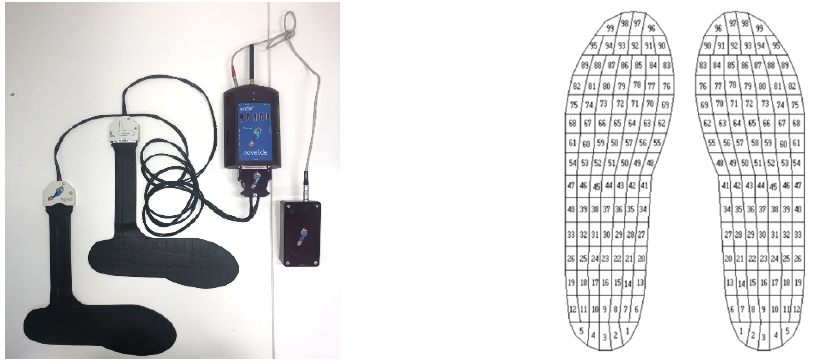
Figure 2. Moticon insoles and the number of sensors covering the insole area (not to scale). The Pedar-x insole system measures left and right pressure distribution and calculates reaction force and temporal-spatial variables. The system has a mass of 0.36 kg, with each insole containing 99 embedded capacitive sensors covering 100% of the insole area (Figure 3). The Pedar-x insoles sample at 50 Hz, with a pressure measurement range of 15–1200 kPa. The Pedar hardware and Pedar-x Expert (22.3.3, Novel GmbH, München, Germany) software was used to collect the data. Pedar-x insoles were calibrated by the manufacture prior to testing. Insoles were configured (configuration allows for the software to identify calibration files) and zeroed prior to each test by unloading each insole, so there was no load on the insoles [29].